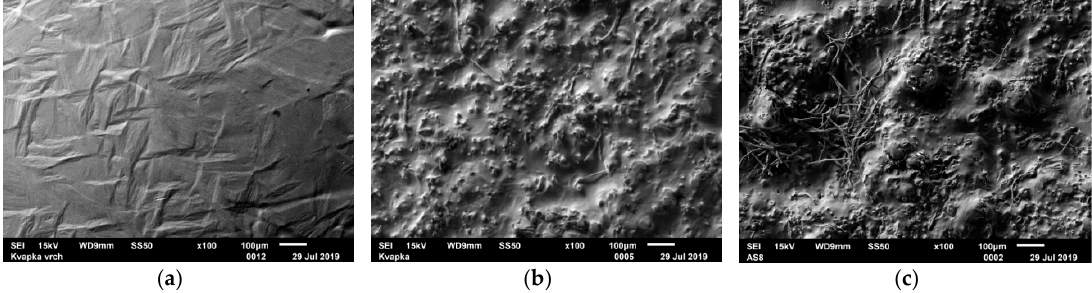
Figure 7. The surfaces of titanium samples after solar metallurgy (SEM): ( a ) small sample upper surface; ( b ) small sample reaction surface; ( c ) large sample reaction surface.